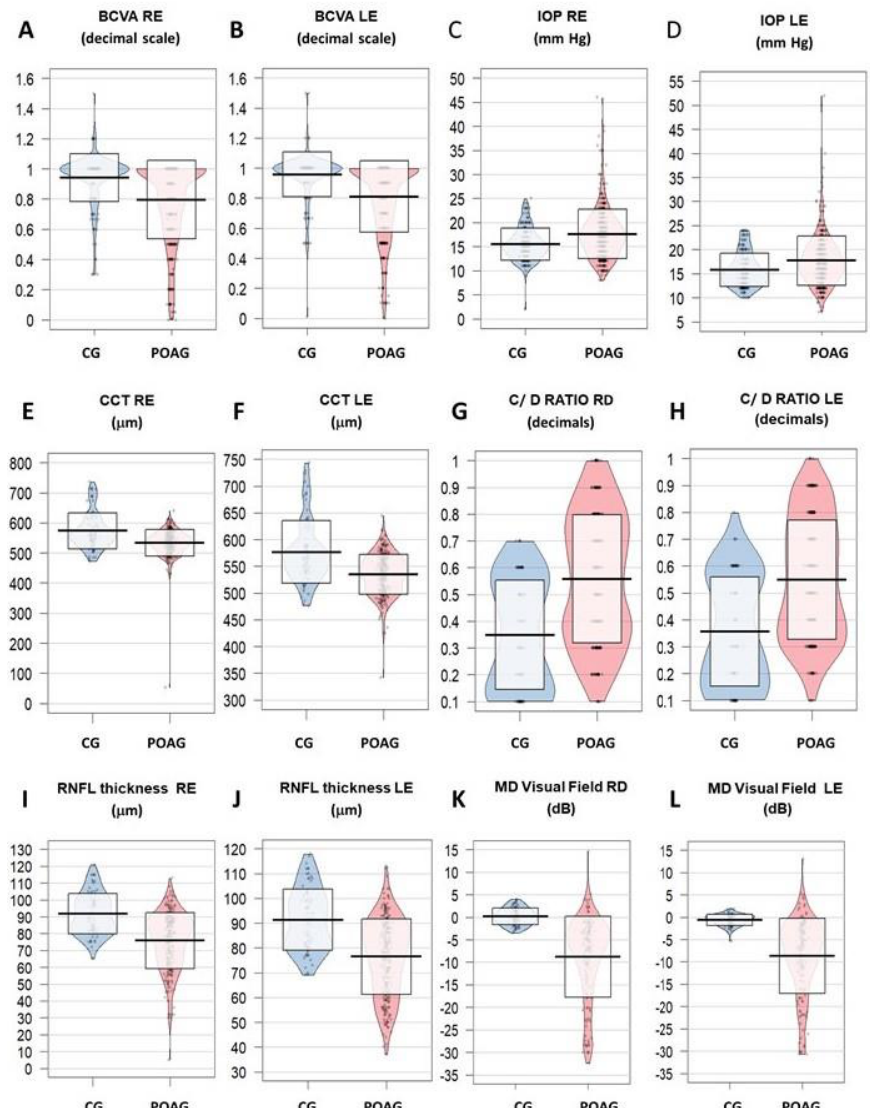
Figure 1. Ophthalmological evaluation of the study participants. ( A , B ) show the best corrected visual acuity (BCVA) (expressed in decimals; see the LogMAR correspondence in the text) in the right and left eyes. ( C , D ) indicate the IOP values (mmHg) in both eyes. In the ( E , F ), the CCT (in µm) from each eye was reflected. ( G , H ) display the C/D ratio in the eyes of the study participants. ( I , J ) show the RNFL thickness observed in the OCT examination from the participants eyes. Finally the ( K , L ) reflect the MD values obtained from the VF performance in both eyes. CG: control group; POAG: primary open-angle glaucoma; RE: right eye, LE: left eye; BCVA: best corrected visual CCT: central corneal thickness; C / D ratio: cup to disc ratio; RNFL: retinal nerve fiber layer; OCT: